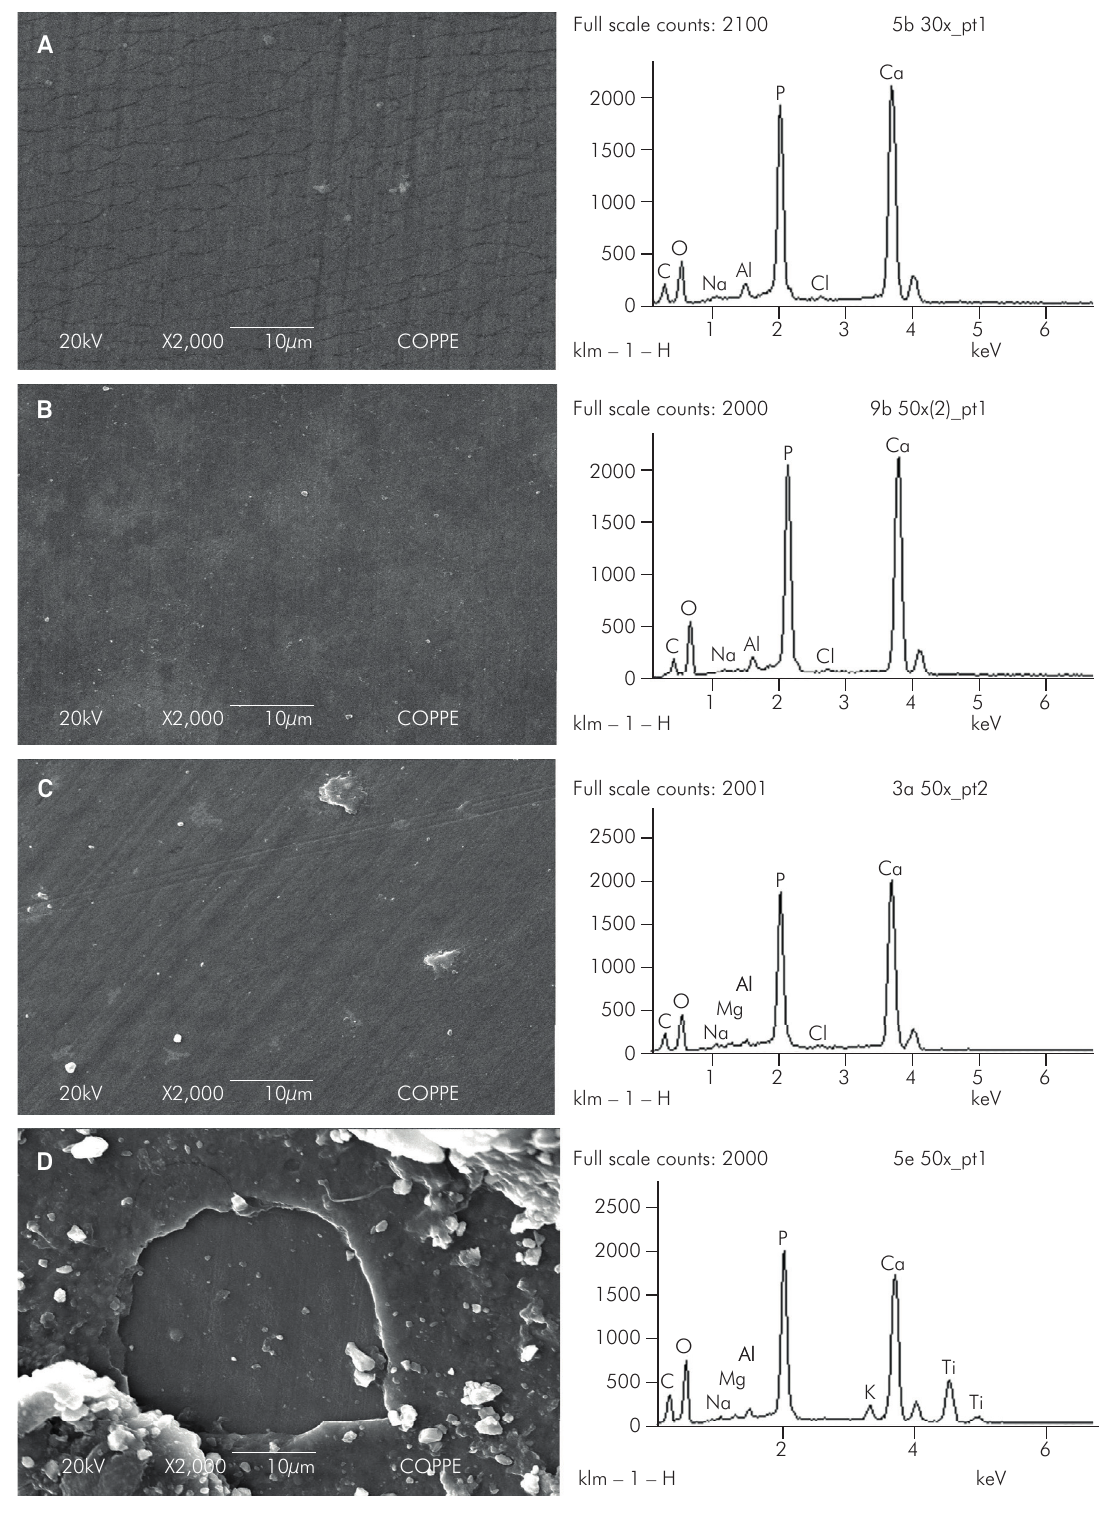
Figure 2. Surface SEM images of enamel samples after 14 days of treatment at 2000x (left) and EDS analysis (right). (a) Negative control, (b) Placebo varnish, (c) NaF varnish and (d) TiF 4